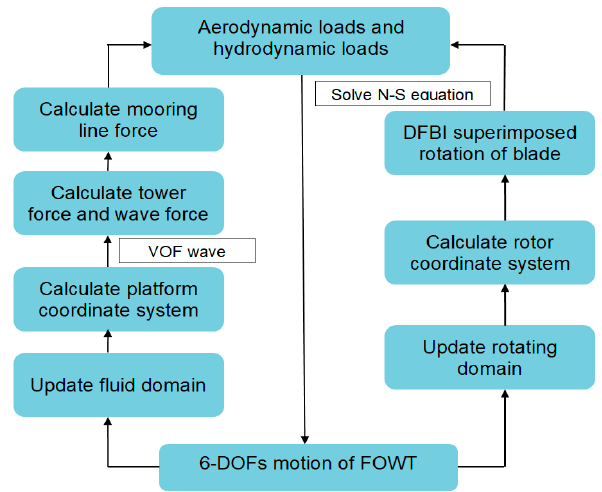
Figure 12. Flow chart of fully coupled simulation in the wind–wave condition.